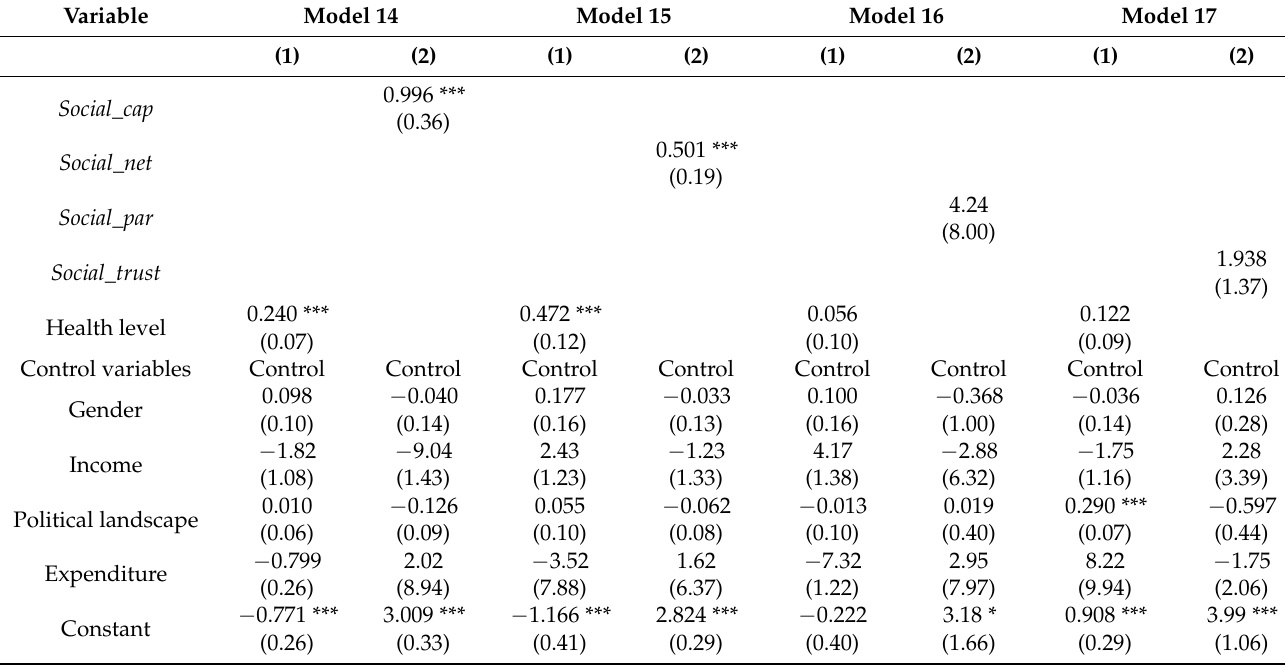
Table 5. IV-reg2 regression